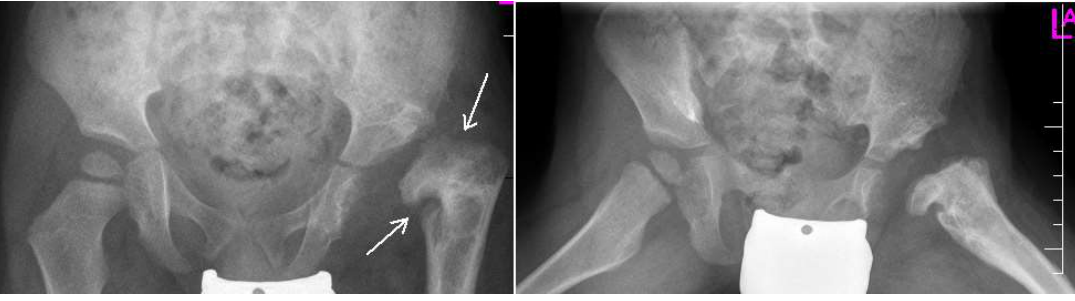
Figure 3. Radiographs: AP and Lauensteun with postrezidual deformity in the same patient after 2 years.